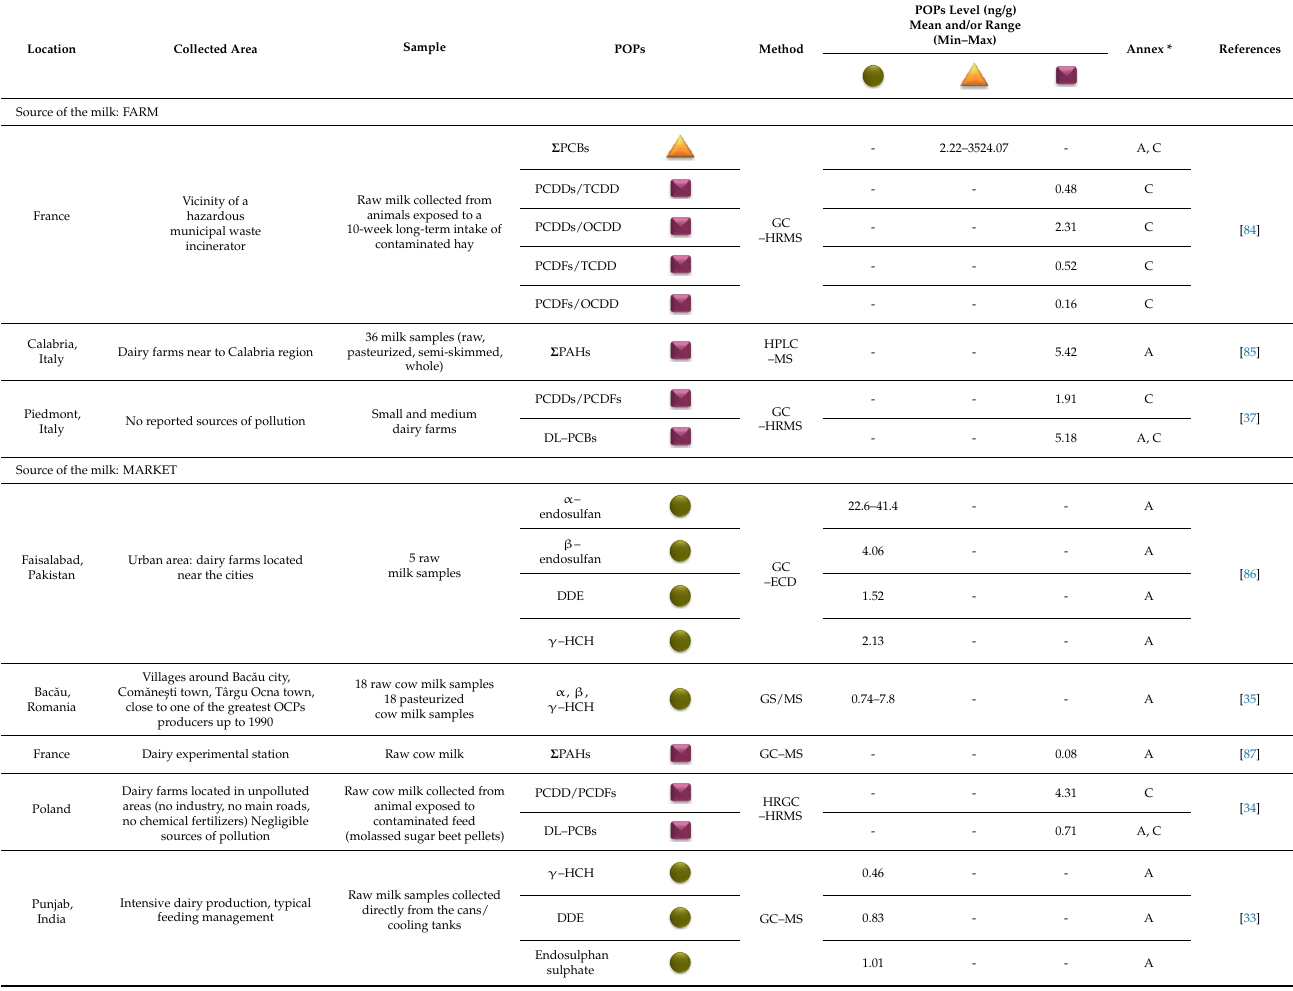
Table 2. Summary of POPs presence in milk and sources of